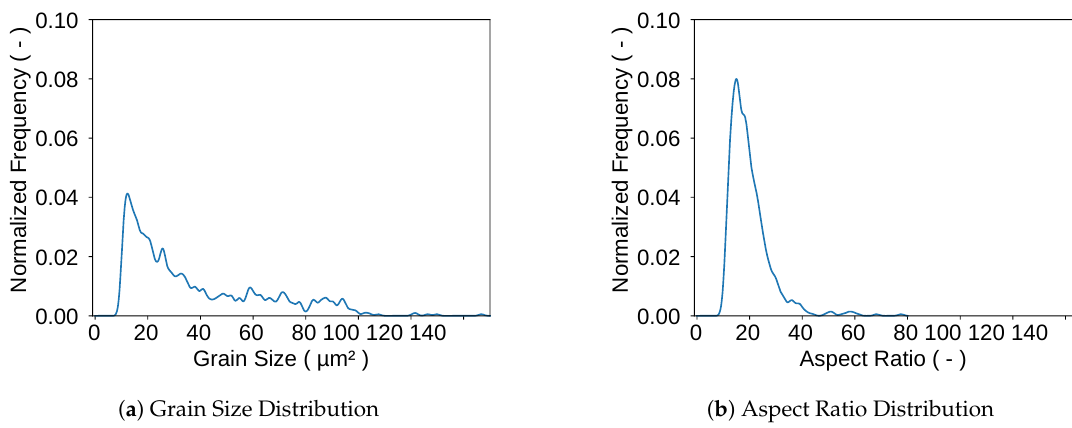
Figure 2. Distributions of Grain Size and Aspect Ratio used as Input data for the Representative Volume Element